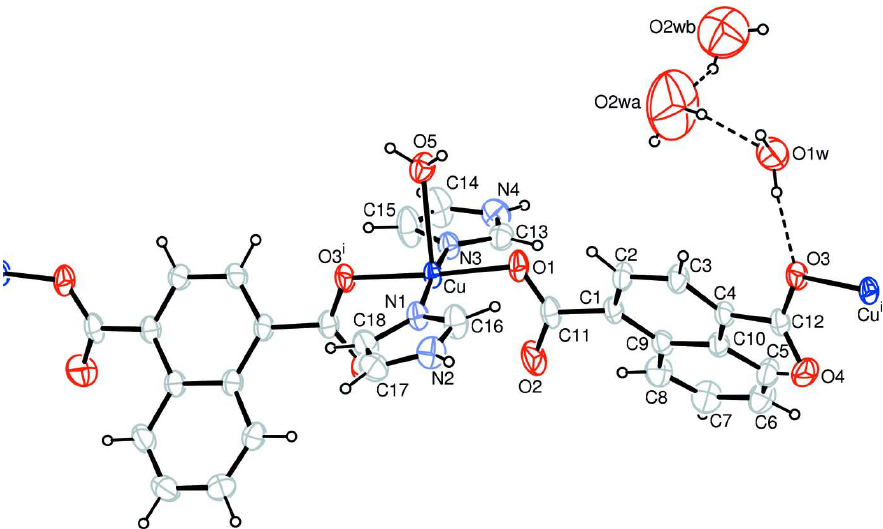
Figure 1 A segment of the polymeric chain of the title compound with 30% probability displacement ellipsoids (arbitrary spheres for H atoms); dashed lines indicate hydrogen bonding [symmetry codes: (i) x + 1/2, - y + 1/2, z - 1/2; (ii) x - 1/2, - y + 1/2, z + 1/2].